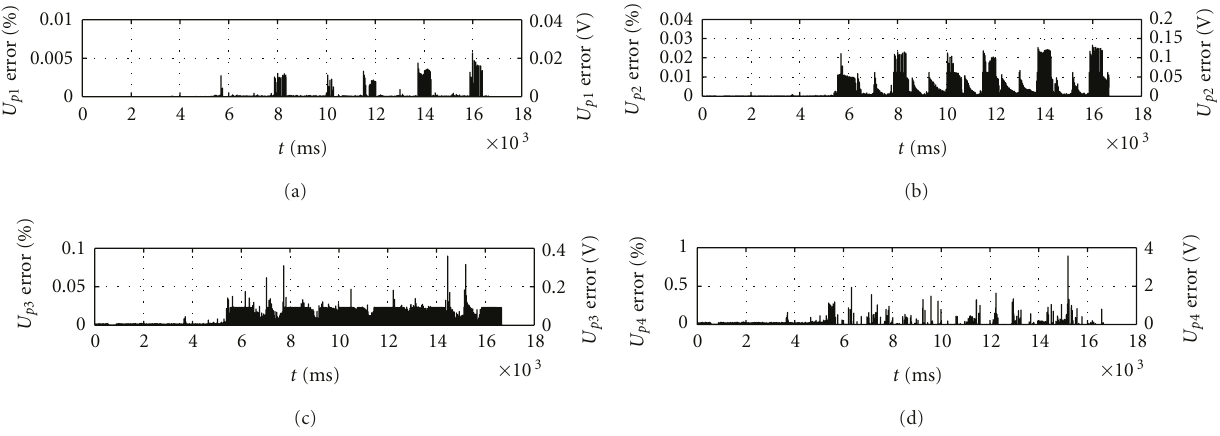
Figure 9: Comparison between simulationresults using numerical solution and using approximations for the reduced power supply